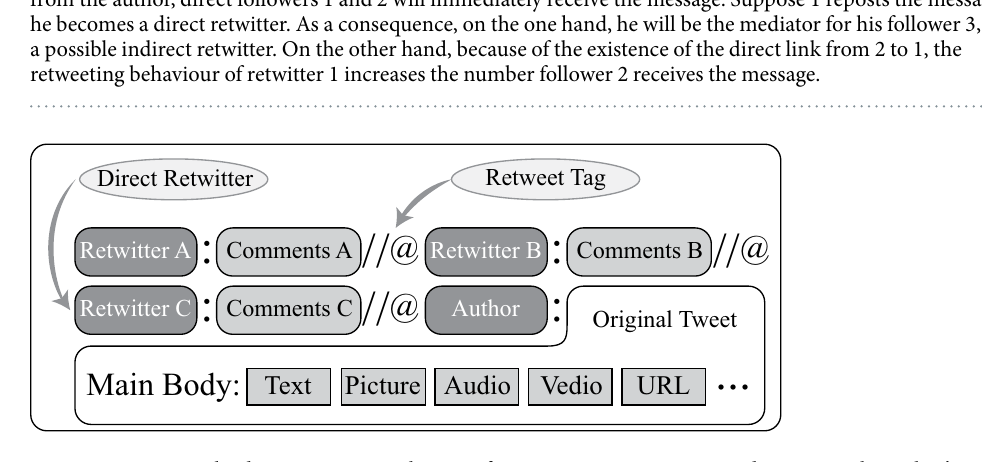
Figure 4. Locating the direct retwitter in the text of a retweet. Retwitters C, B and A retweet the author’s original tweet chronologically. Retwitter C is the closest to the author. Thus, C is reckoned as a direct